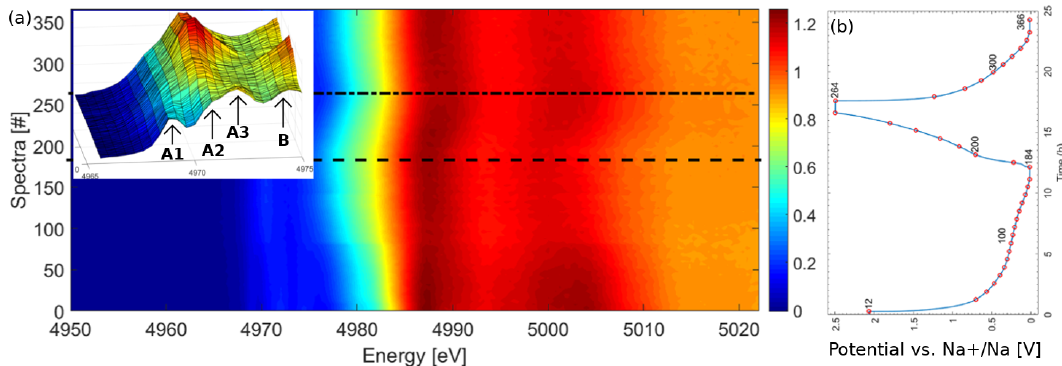
Figure 1. ( a ) Evolution of operando Ti K-edge XANES of TiO 2 anatase electrode vs. Na. Dashed line indicates the end of first discharge (#184) and dashed-dotted line the end of charge (#264). The inset shows the evolution of the four indicated pre-edge features A 1 , A 2 , A 3 and B in the range from 4965 to 4975eV. ( b ) Corresponding electrochemical cycling curve of the first 1,5 electrochemical cycles of TiO 2 vs. Na.